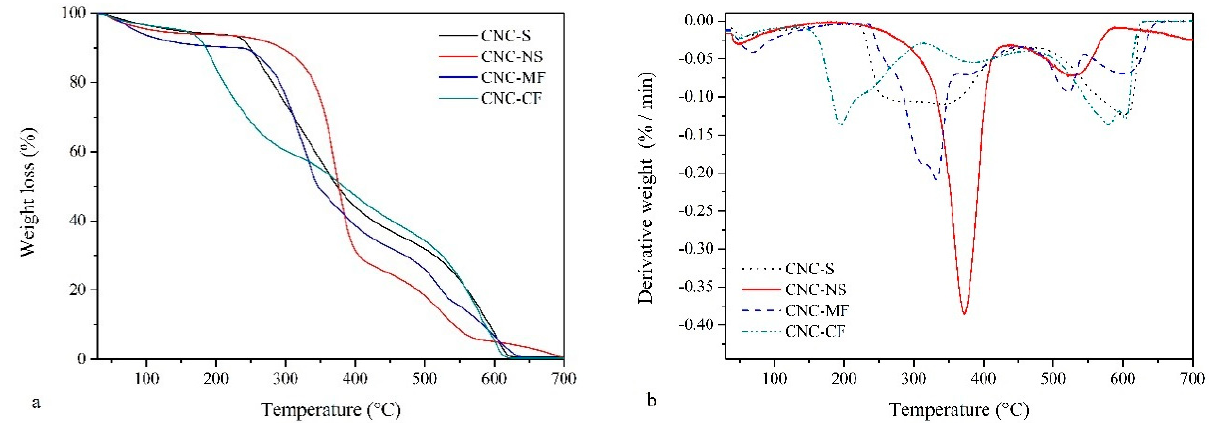
Figure 9. TGA ( a ) and DTG ( b ) curves for CNC’s powders.